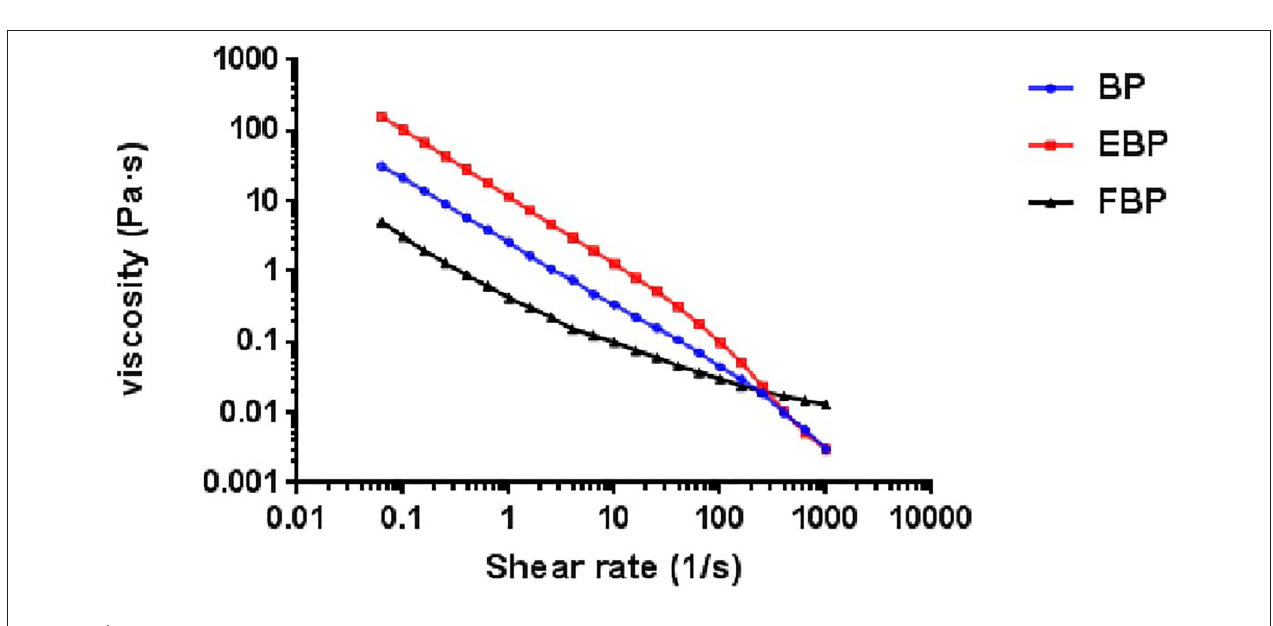
FIGURE 1 | The static viscoelasticity of BP, EBP, and FBP.